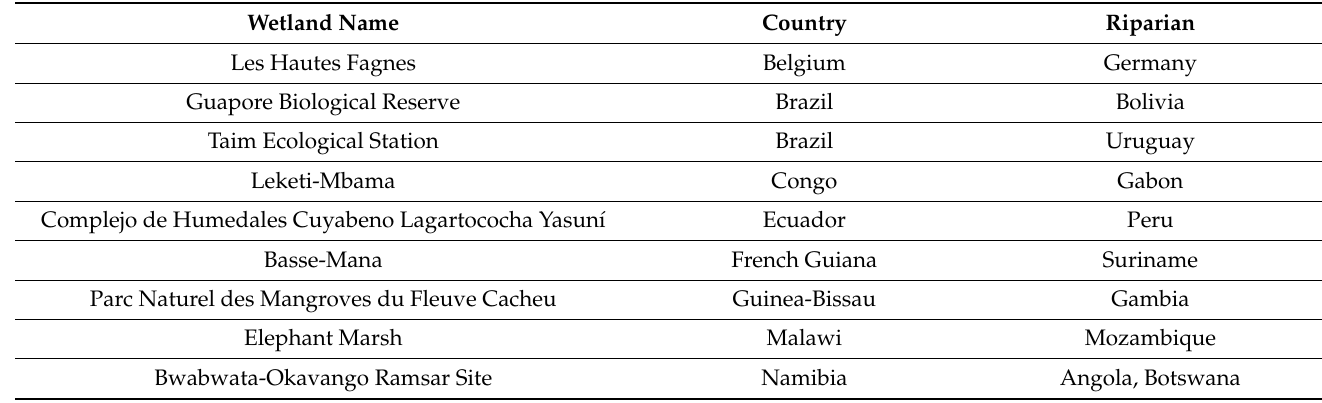
Table 4. Transboundary Ramsar Sites we identified by spatial analysis. (Data sources: Ramsar Sites Information Service; UIA World Countries Boundaries